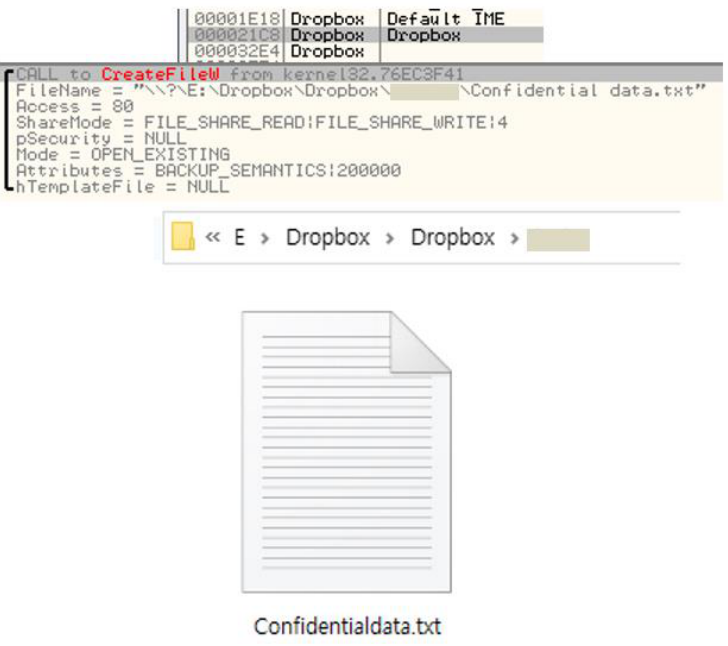
Figure 2. Extracting the file path synchronized to Dropbox.